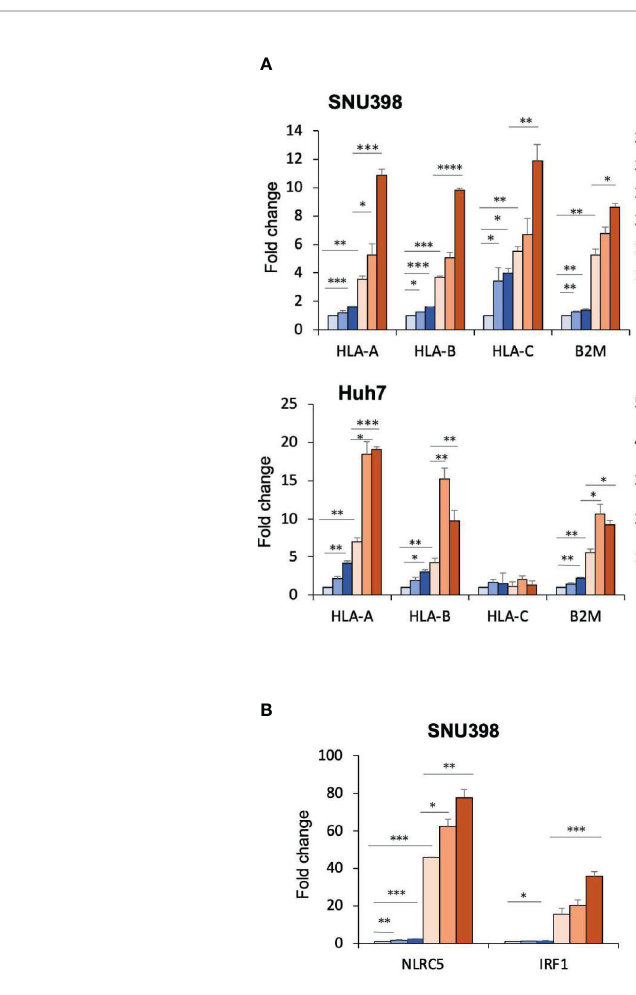
FIGURE 2 | Regorafenib increases gene expression of HLA-I as well as the related transcriptional regulators NLRC5 and IRF1. (A, B) SNU398 or Huh7 cells were treated with regorafenib (5 m M) for the indicated times in the absence or presence of IFN g (1 ng/mL) for 48 hours. mRNA levels were measured using real-time PCR. Data are expressed as fold change relative to vehicle-treated cells. Reg, regorafenib. (*: p < 0.05, **: p < 0.01, ***: p < 0.001, ****: p <